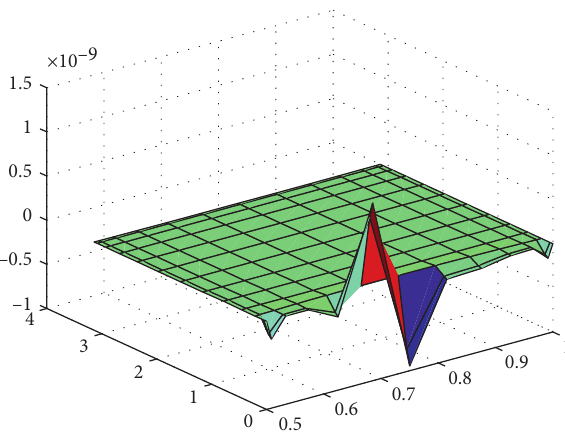
Figure 4: Errors of quasi-equidistant nodes with m � n � 12. Table 3: Convergence rate of quasi-equidistant nodes with different d